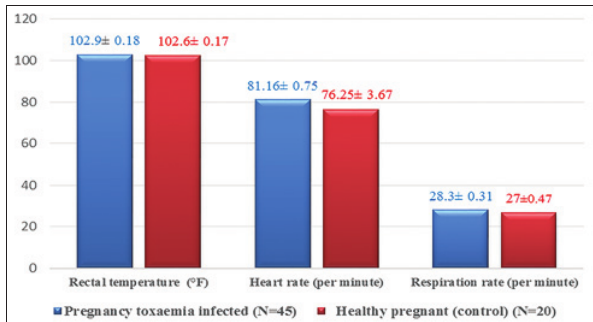
Figure-1: Mean±standard error values of vital signs of healthy pregnant and pregnancy toxemic goats.